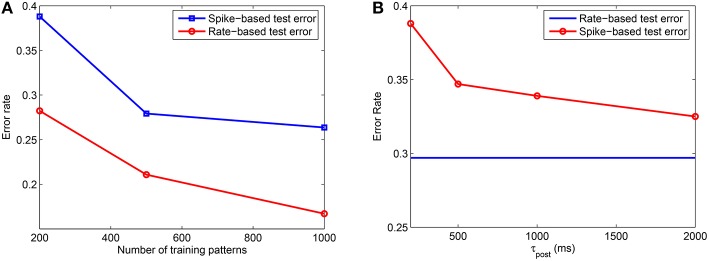
(A) Comparison of performance of rate-based and spike-time-based learning schemes. The test error rates for the spike-based learning rule are about 1.5 times higher than the rate-based test errors; (B) Comparison of test error rate for P = 200 patterns learned with rate-based (blue line) and spike-based (red plot) methods as a function of τpost. Each data point is obtained by averaging over 3 training simulation trials and testing on 10, 000 single spike inputs with jitter Δ = 10 ms; m = 10 and k = 10.